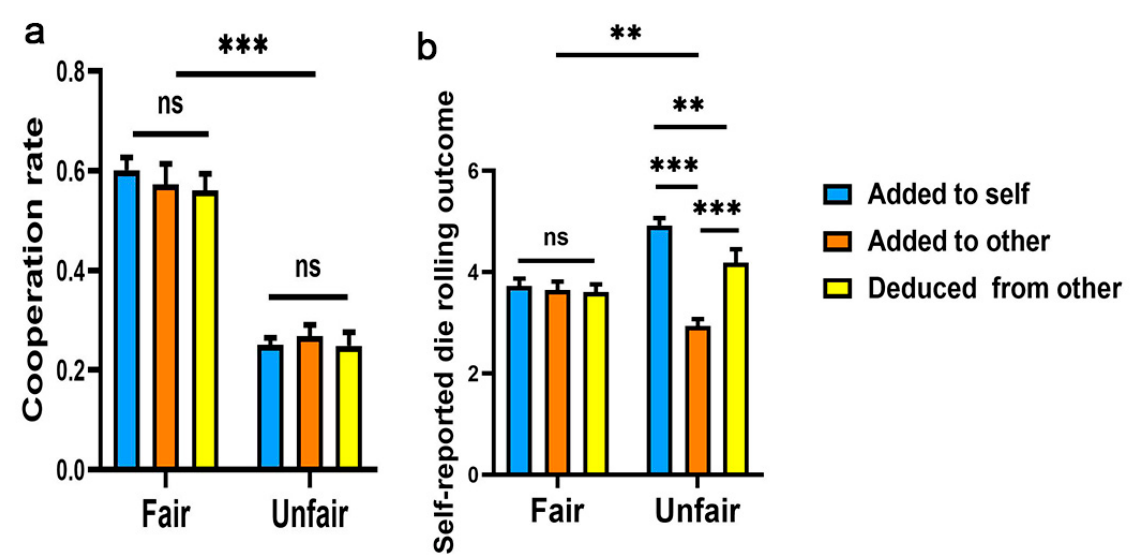
Figure 3. Results from Exp. 2. Averaged ( a ) cooperation rate and ( b ) outcome of die-rolling as a function of point system (added to self vs. added to opponent vs. deducted from opponent), separately for the fair condition and the unfair condition. Error bars indicate standard error. **: p < 0.01,***: p < 0.001, ns: no significant difference.